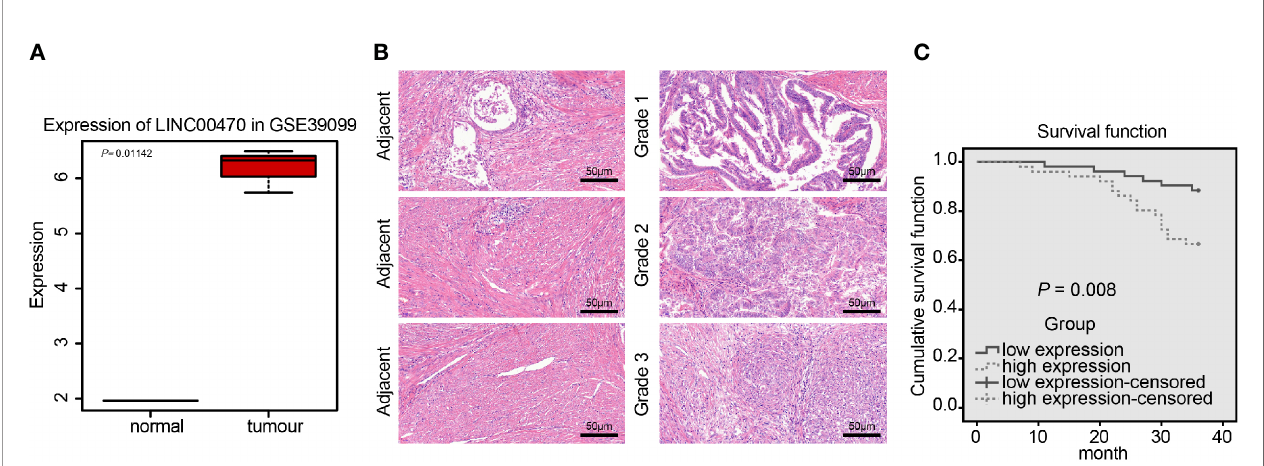
FIGURE 1 | LINC00470 was overexpressed in EC and related to the poor prognosis of EC patients. (A) Expression box diagram of LINC00470 in the dataset GSE39099 (left panel); RT-qPCR determination of the LINC00470 expression in 103 EC tissues and adjacent normal tissues (right panel). (B) The expression of LINC00470 in EC tissues and adjacent normal tissues assessed by ISH, scale bar = 50 m m (left panel); the pathological changes of EC tissues and adjacent normal tissues assessed by HE staining (right panel), scale bar = 50 m m. (C) Kaplan-Meier analysis of the prognosis of EC patients with high or low expression of LINC00470. Data comparison between two groups were performed using independent sample t-